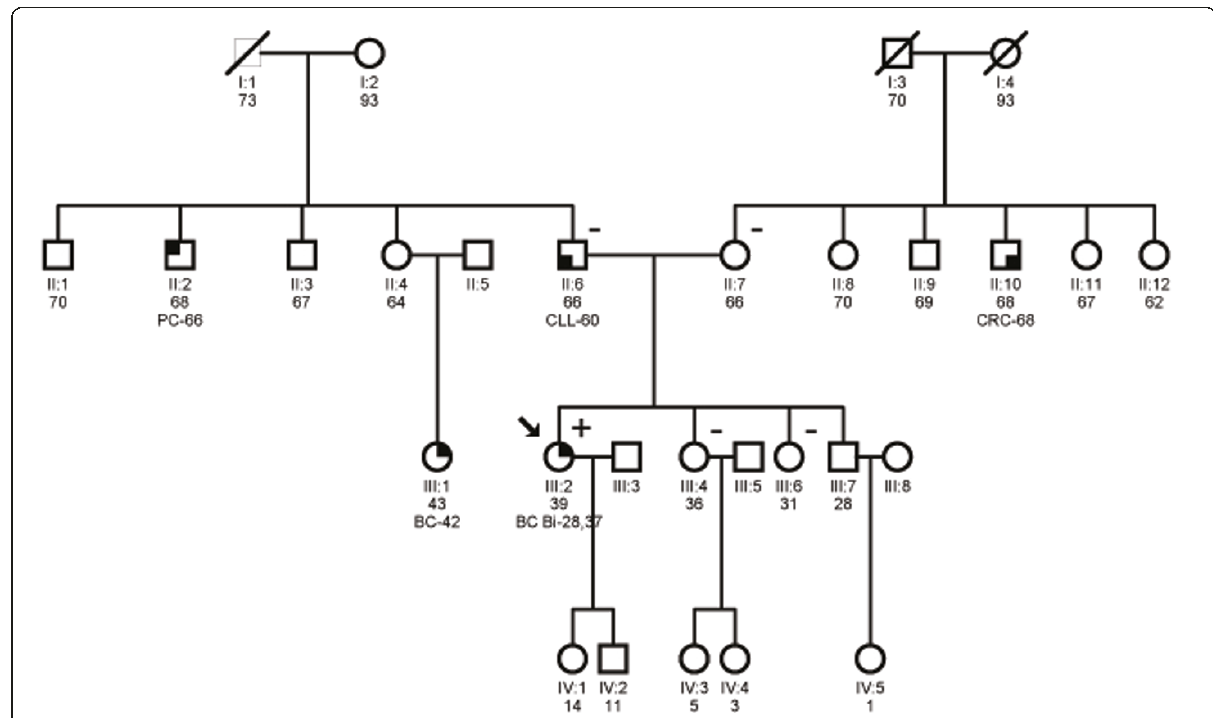
Figure 1 Patient ’ s family pedigree displaying breast cancer . Black shading indicates individuals with cancer. The patient (proband) is individual III:2 and is arrowed. The current age and the age at diagnosis of cancers are indicated below. The genotypes (where DNA available for analyses) are shown as: - for wild-type homozygous, and + for heterozygous for BRCA1 complete deletion. PC: prostate cancer; CLL: chronic lymphocytic leukaemia; CRC: colorectal cancer; BC: breast cancer; Bi BC: bilateral breast